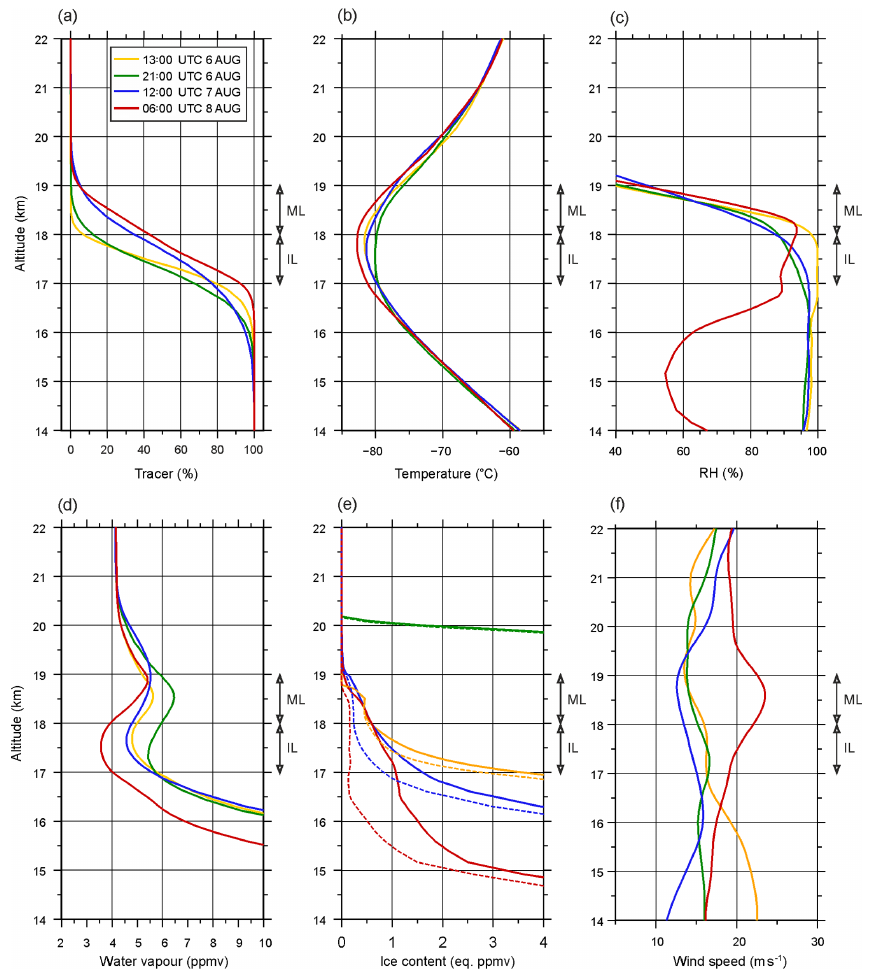
Figure 11. Vertical profiles of (a) tracer (%), (b) temperature ( ◦ C), (c) relative humidity (%), mixing ratios of (d) water vapour (ppmv), (e) ice content (eq.ppmv), and (f) wind speed (ms − 1 ) across the hydration patch along the trajectory at 13:00UTC (yellow line), 21:00UTC (green line) on 6 August, 12:00UTC on 7 August (blue line), and 06:00UTC (red line) on 8 August 2017. The layers of the ML and IL are marked by arrows. In (e) , the ice content is depicted by solid lines, while the cloud ice is shown by dashed